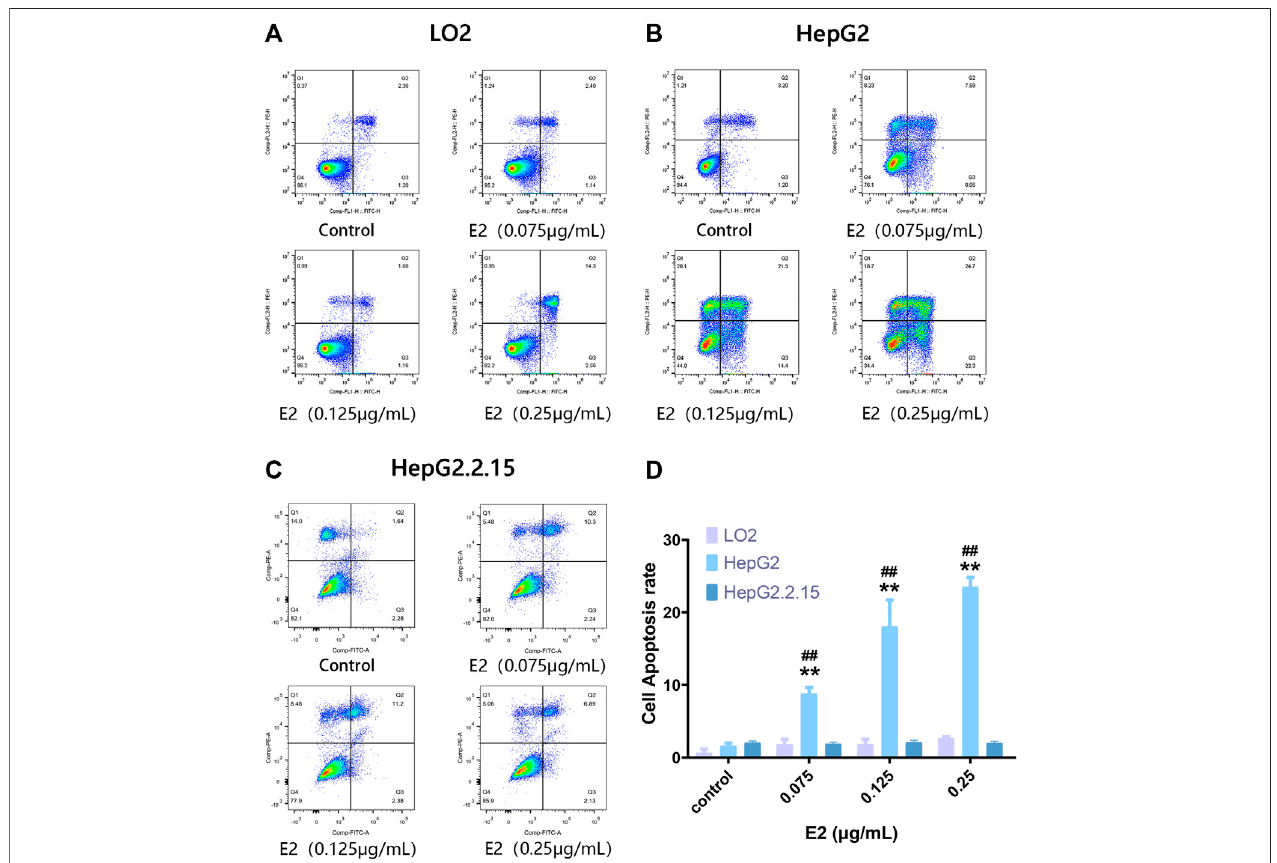
FIGURE2| TheextentofapoptosisofHepG2,HepG2.2.15,andLO2cellstreatedwith17 β -estradiol. (A – C) Tetradplotsshowingtheeffectsonthethreecelltypes after48 h.AnnexinV-FITC/PIdouble-stainingwasusedtomeasuretheproportionsofapoptoticcells. (D) ThehistogramshowstheapoptoticproportionsofHepG2and LO2 cells. All experiments were performed in triplicate. ** p < 0.01 compared to the control group, ## p < 0.01 compared to LO2 cells at the same dose.